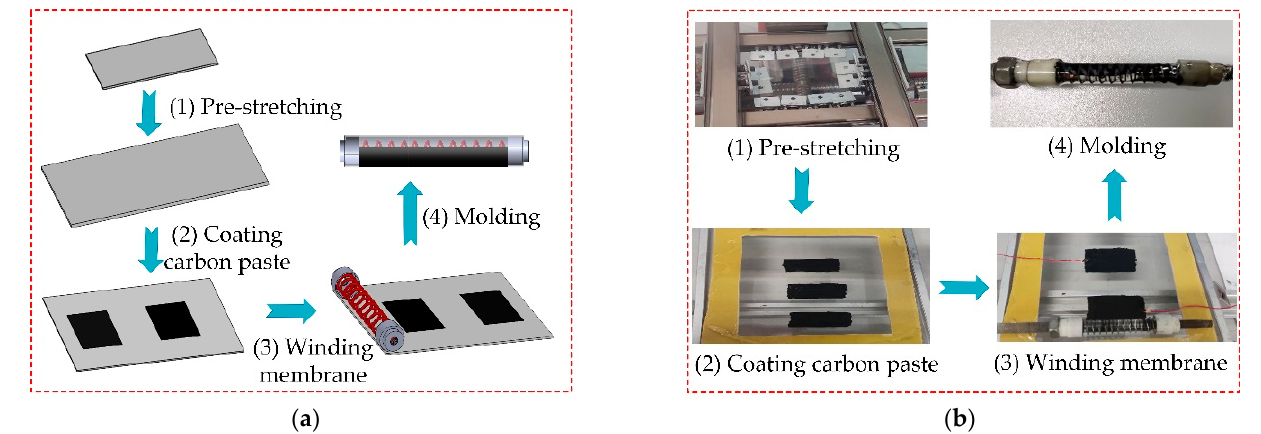
Figure 9. The production process of the soft finger. ( a ) The theoretical design process. ( b ) The ex- perimental process.